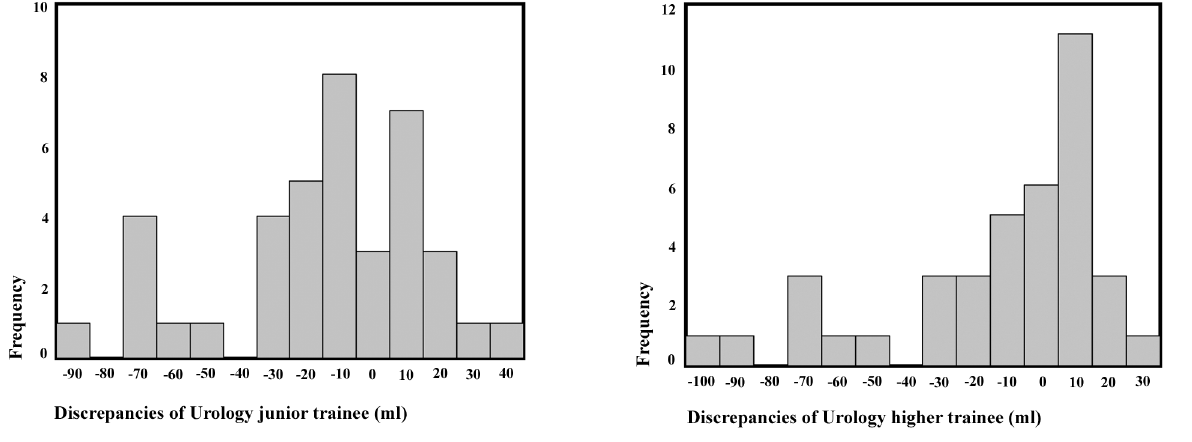
Figure 4 – Frequency distribution of discrepancies for urology junior trainee.